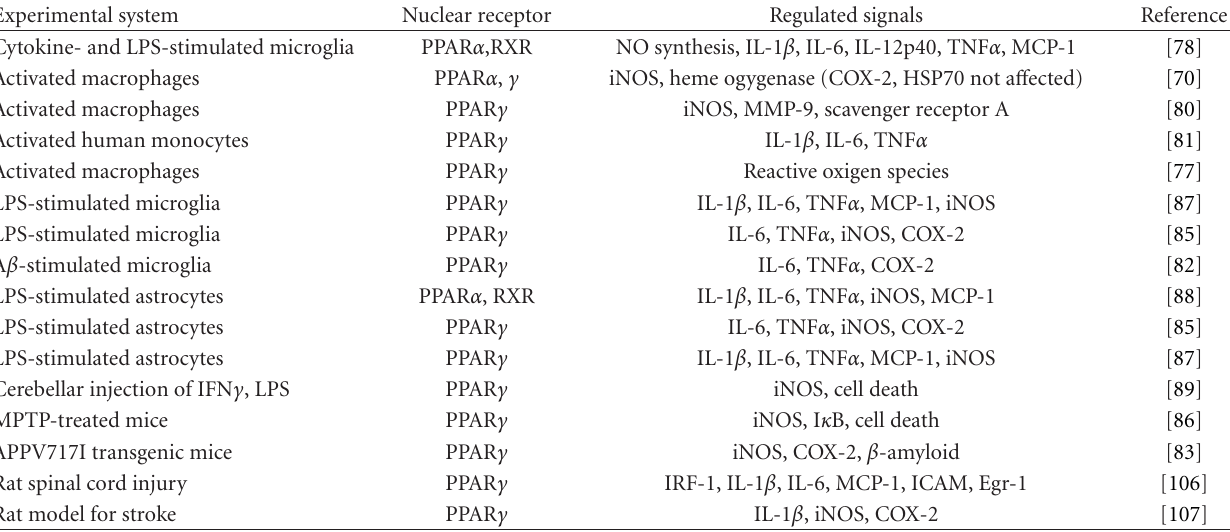
Table 1: Anti-inflammatory e ff ects of PPAR α and PPAR γ agonists on the molecular level. Experimental